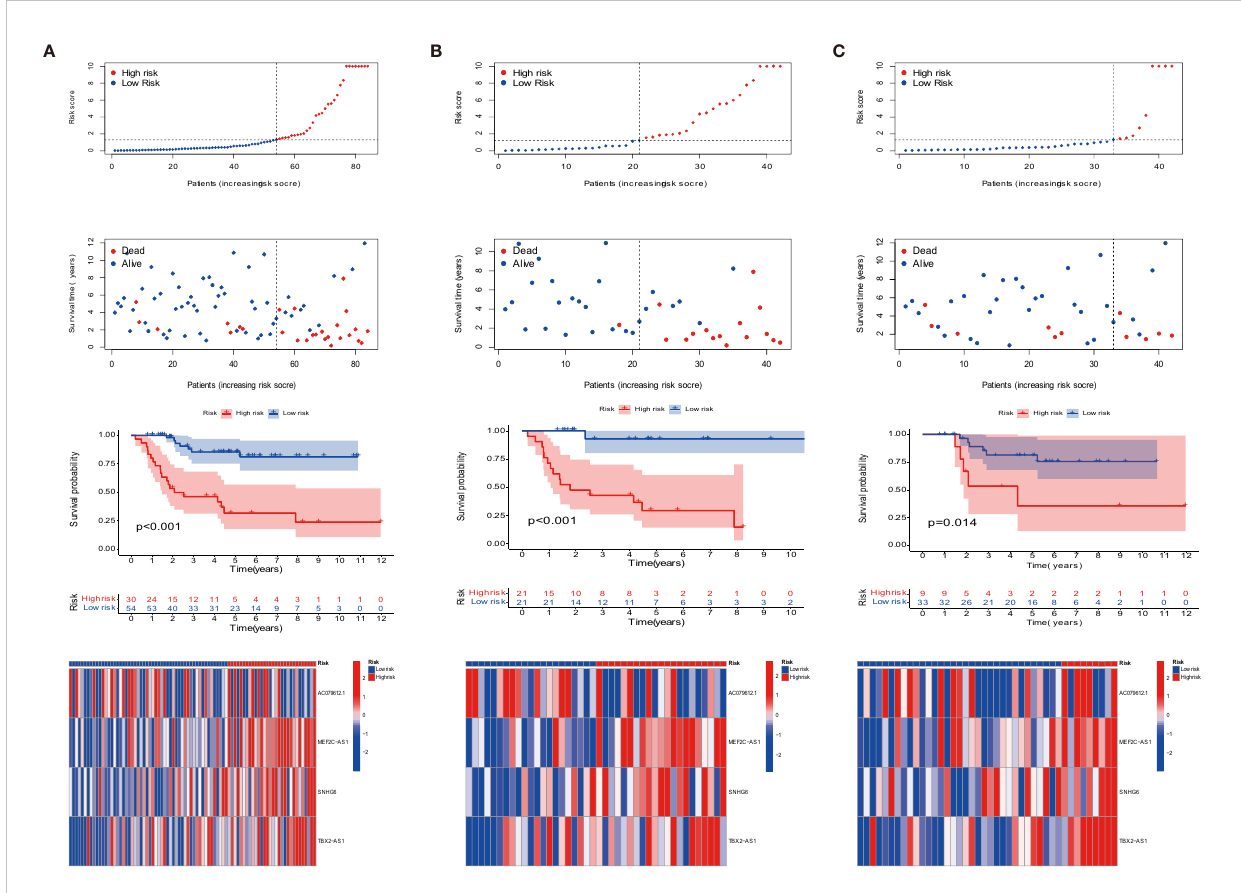
FIGURE 2 Prognosis of the risk model in the entire, training, and testing sets. (A – C) Survival time, survival status, Kaplan – Meier survival curves of patients with OS, and heat map in the expression of four lncRNAs in the entire, training, and testing sets,